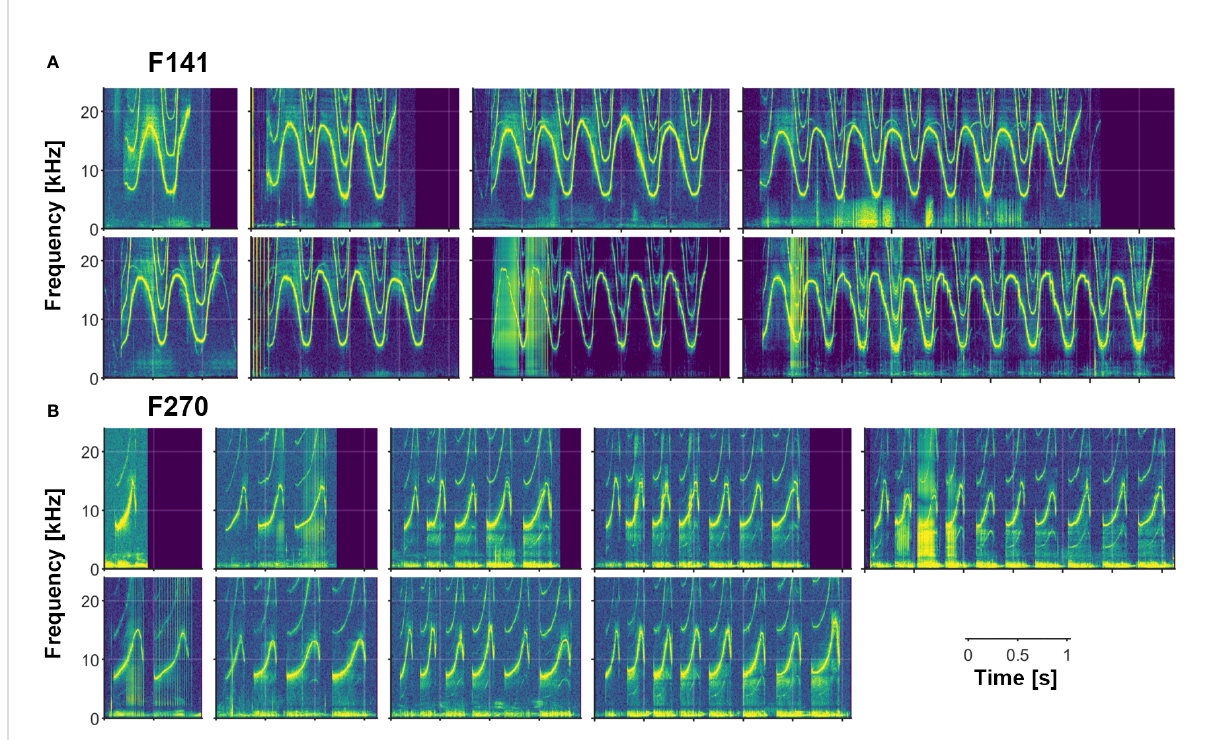
FIGURE 6 Examples of varying numbers of loops in multi-loop signature whistles. (A) F141 produces a connected multi-loop whistle containing 1 to at least 11 loops. (B) F270 produces a disconnected multi-loop whistle containing 1 to at least 10 loops (separated by typical inter-loop intervals; see text). [Note also subharmonics in many of F270 ’ s